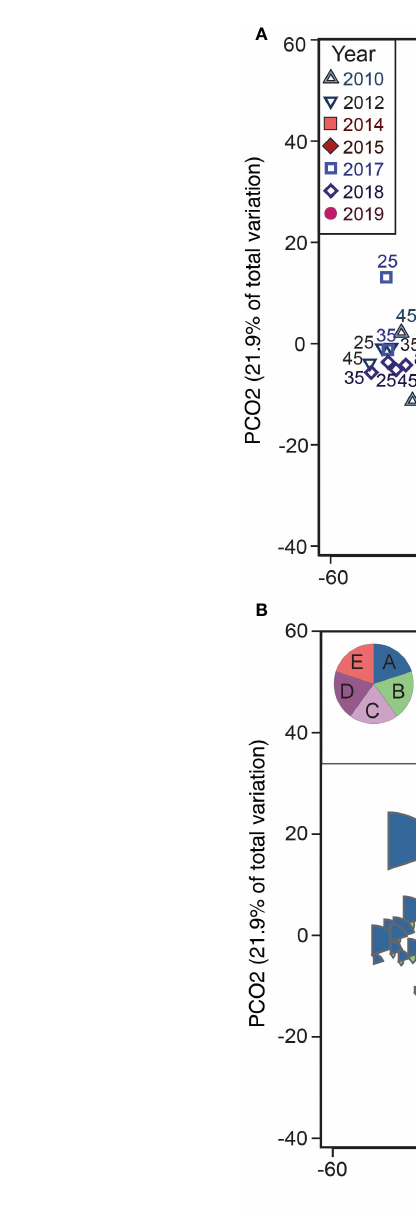
FIGURE 4 Foraminiferal assemblages highlighting annual and species distribution patterns. The foraminifera abundance data shown in a principal coordinates ordination analysis (PCOA) plot of square-root transformed Bray-Curtis resemblance matrix for all foraminifera abundance data (excluding 2016). The axes in A and B are identical. The upper plot (A) highlights the patterns in different stations and different years, and the lower plot (B) includes patterns in species abundances, with the fi ve most abundant species plotted as bubbles. All slices of the bubbles are scaled from the foraminifera density (0-4 # m -3